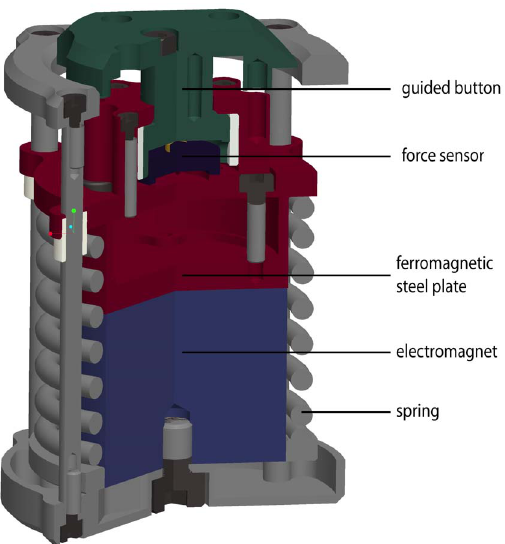
Figure 3. Grasp Perturbator held in a pinch grasp with attached